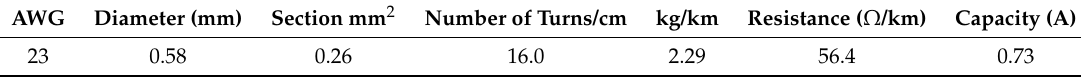
Table 1. Features of 23-AWG